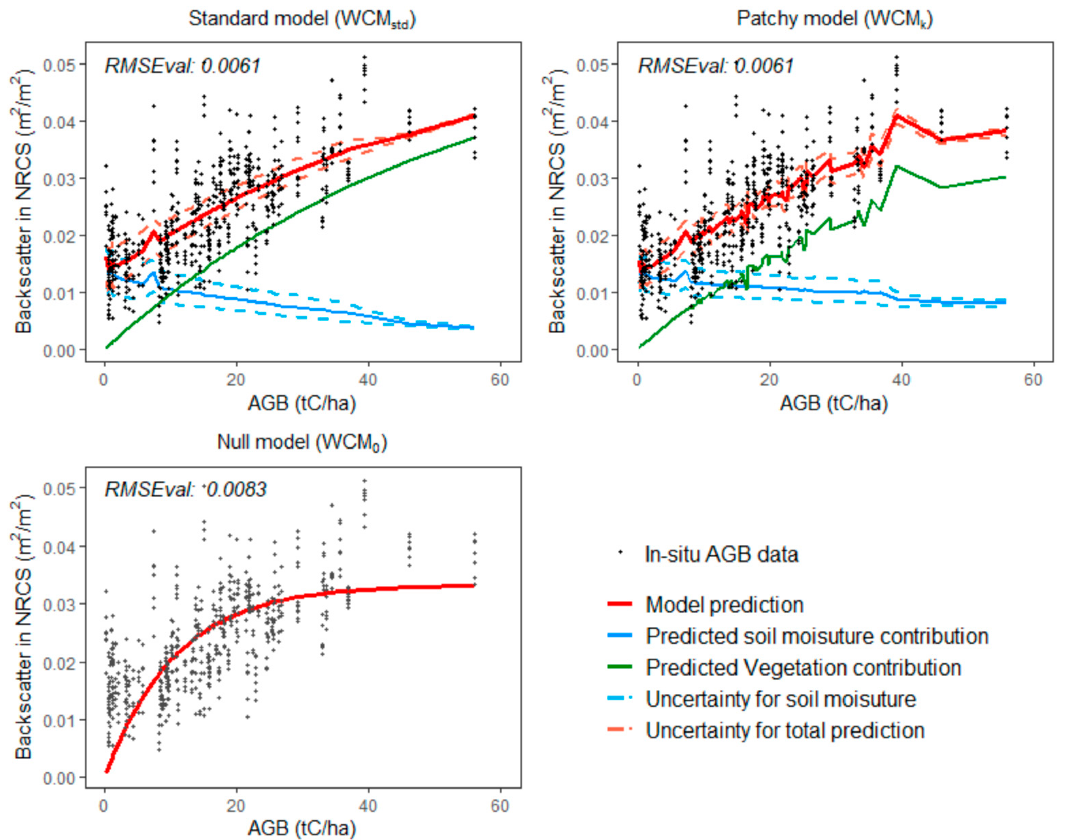
Figure 5. In situ AGBC data and fitted forward WCM s (WCM std , WCM k , and WCM 0 ) with separate lines illustrating model prediction of total backscatter, vegetation contribution, and soil moisture contribution, covering the range of observed values (0–60 tC/ha). Total backscatter is expressed in normalised radar cross-section (NRCS, m 2 /m 2 ). Fitted parameters a, b, c, and d are provided in Table A2.